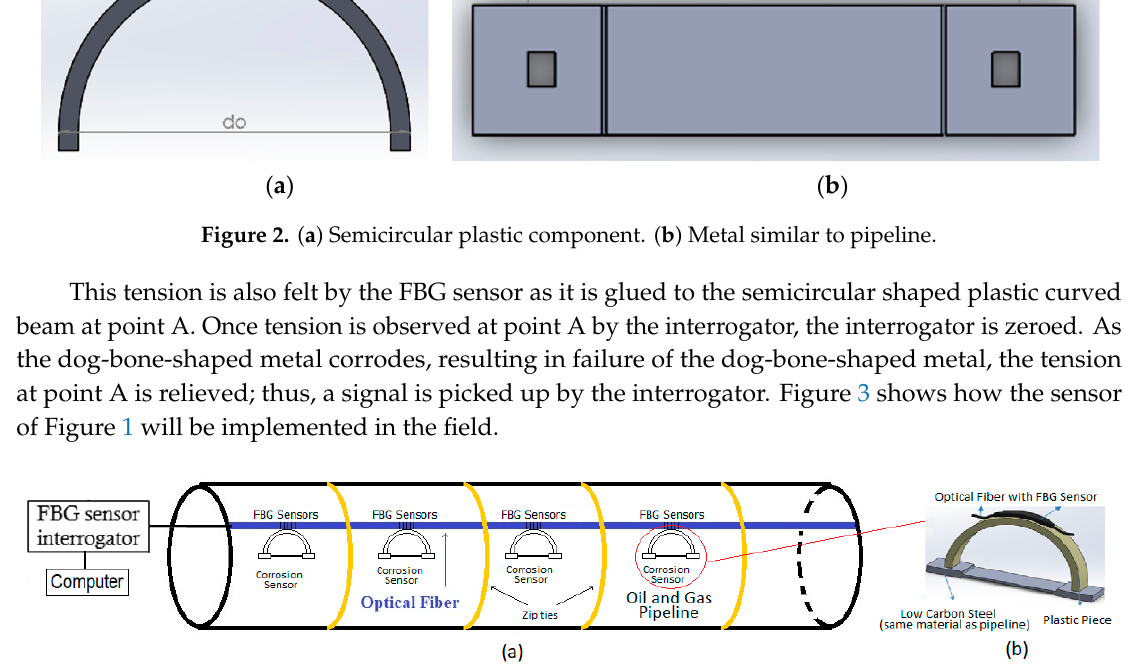
Figure 3. An O&G pipeline with external corrosion detection sensors, spaced every few meters. ( a ) Pipeline with an optical fiber and corrosion detection sensors, ( b ) Corrosion detection sensor.